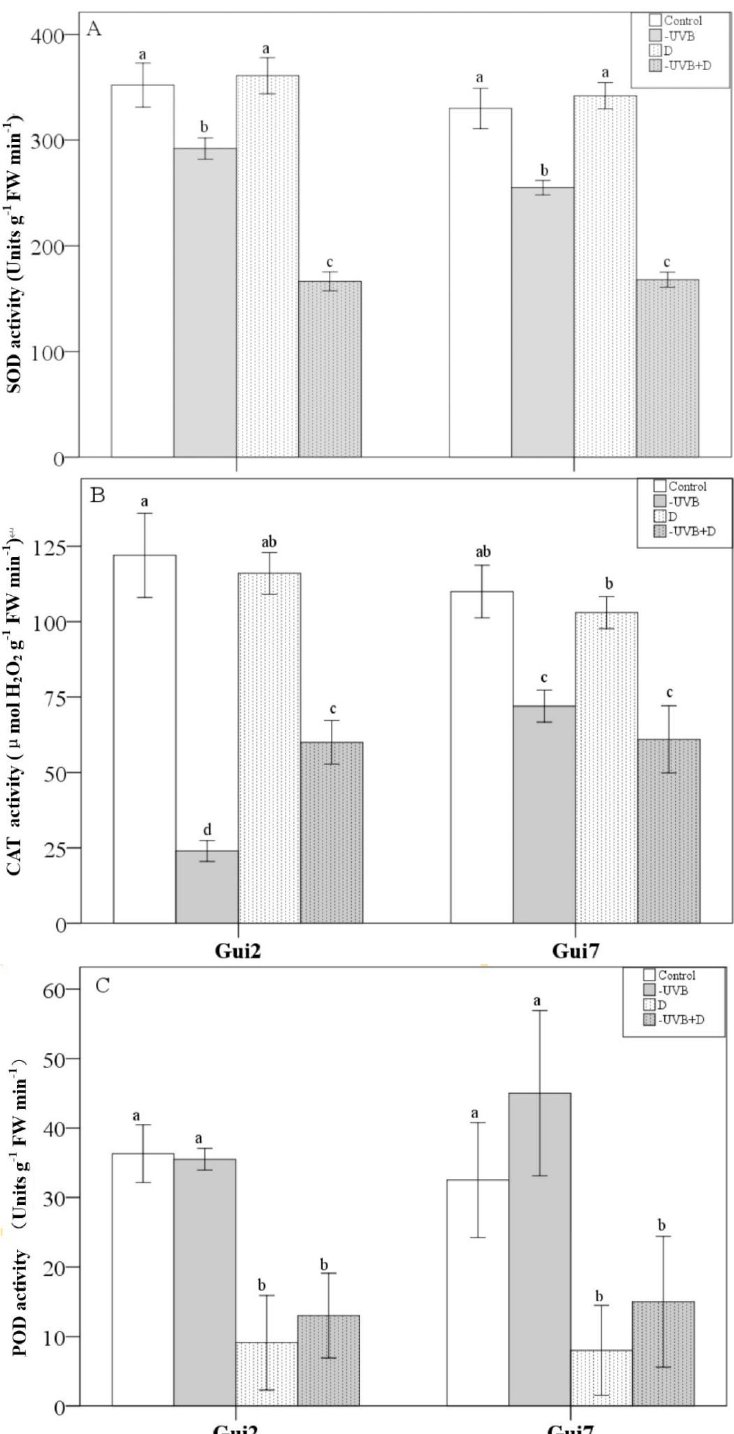
Figure 4. Leaf SOD activity ( A ), CAT activity ( B ), and POD activity ( C ) of two Chestnut rose cultivars under different water regimes and solar UV-B treatments. Values are mean ± SD. Different letters above the bars indicate significant difference between treatments at p < 0.05 level by LSD pairwise comparisons. Control, ambient UV-B; –UV-B, UV-B exclusion; D, drought with ambient UV-B; –UV-B+D, drought with UV-B